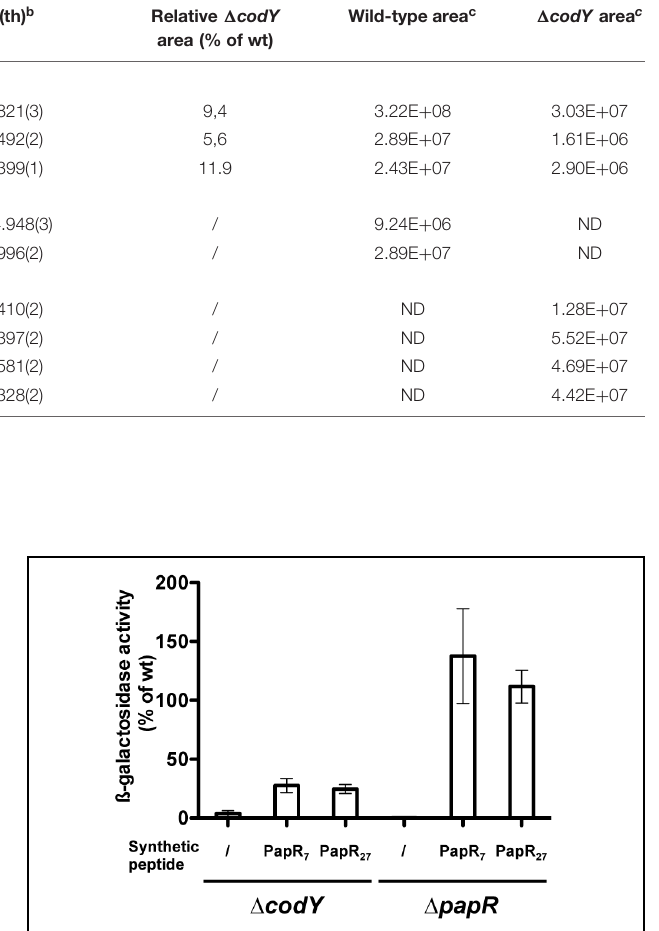
FIGURE 6 | Extracellular complementation assay of (cid:2) codY cells with synthetic PapR peptides. (cid:2) codY and (cid:2) papR cell cultures were split at the entry of stationary phase and synthetic peptides were added when indicated at a final concentration of 5 μ M. The cells harbor the pP plcA ’- Z plasmid, carrying a transcriptional fusion between the promoter of plcA and lacZ. Cells were grown in LB at 37 ◦ C. Samples were collected for β -galactosidase assay 2.5 h after addition of the peptides. The sequence of the PapR peptides is indicated in Section “Materials and Methods.” The results are the mean values of two independent experiments, and the error bars represent standard